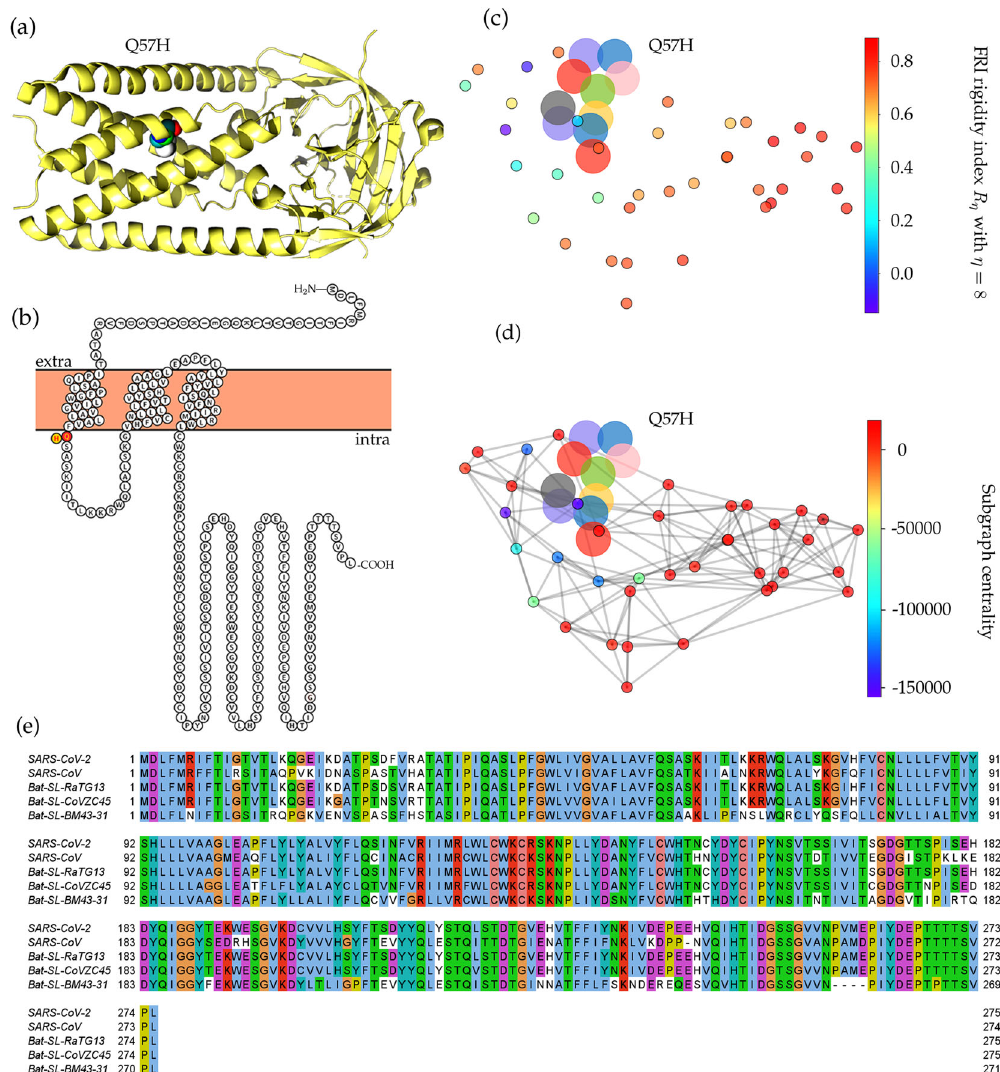
Fig. 5 The 3D structure and network analysis plot of SARS-CoV-2 ORF3a protein. a The 3D structure of SARS-CoV-2 ORF3a protein. b The visualization of SARS-CoV-2 ORF3a proteoform. The high-frequency mutation 25563G>T-(Q57H) on ORF3a is marked in color. The red color represents the wild type and the yellow represents the wild type. c The difference of FRI rigidity index between the network with wild type and the network with mutant type. d The difference of the subgraph centrality between the network with wild type and the network with mutant type. e Sequence alignments for the ORF3a protein of SARS-CoV-2, SARS-CoV, bat coronavirus RaTG13, bat coronavirus CoVZC45, and bat coronavirus BM48-31. Detailed numbering is given according to SARS-CoV-2. One high-frequency mutation 25563G>T-(Q57H) locates on the ORF3a protein. Here, the red rectangle marks the Q57H position with its